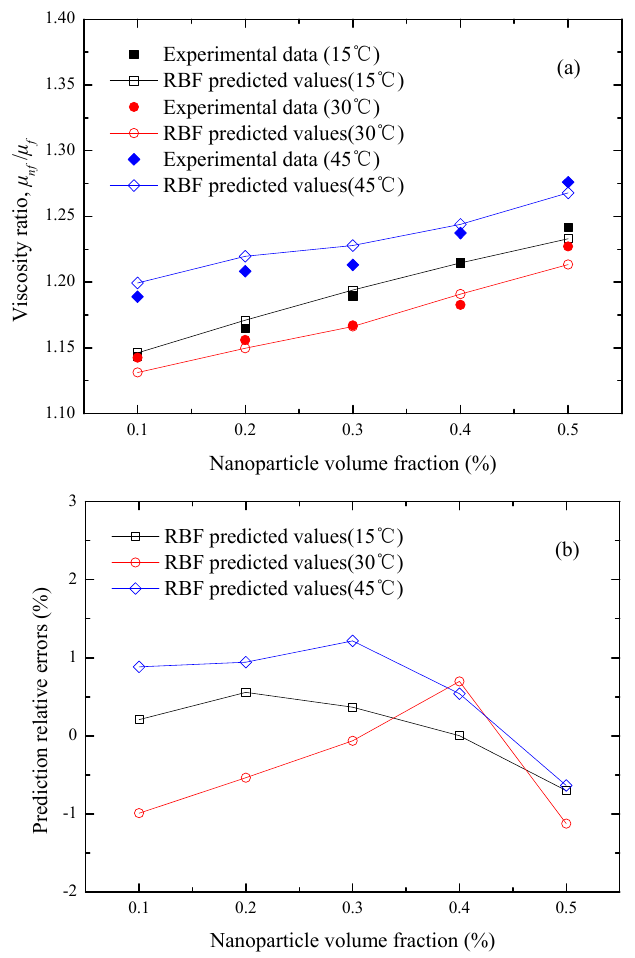
Figure 8. ( a ) Predicted comparisons and ( b ) relative errors of the RBF predicted μ nf / μ f and the experimental data [19] for SiC-ethylene glycol/water (40:60 by weight ratio) nanofluids at d p = 30 nm.